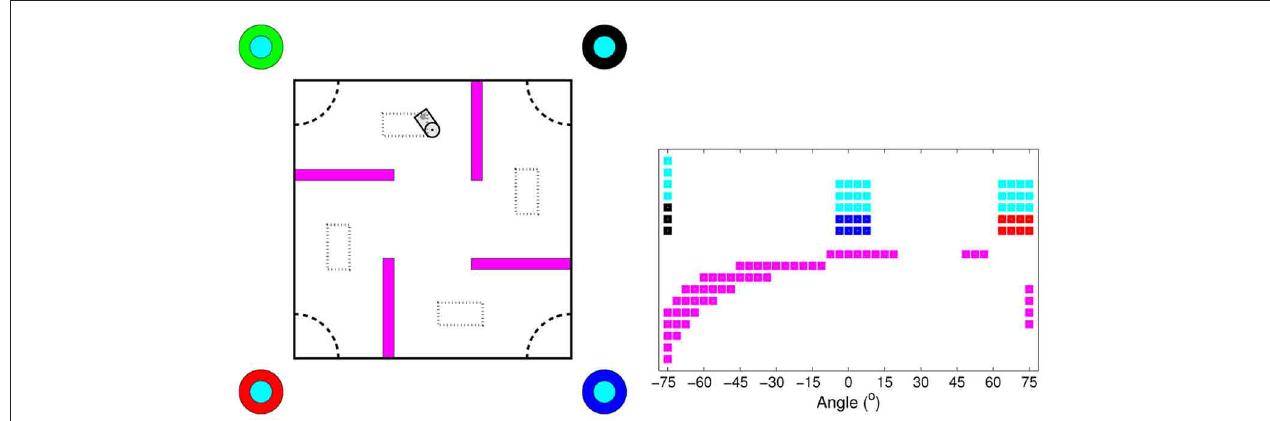
of each landmark was unique and non-changing. The color of the upper part of all landmarks corresponded to the correct goal area and was randomly changed at the start of each episode. Note that the difference in radius between the lower and the upper part of the landmarks is only for illustrative purposes. In the experiments, both parts of the landmarks had the same